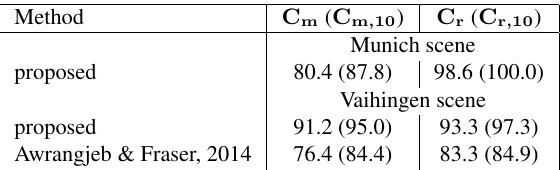
Table 2. Completeness and correctness of the segmentation. Seg- mentation results of the Vaihingen Scene are compared to the re- sults of Awrangjeb and Fraser (2014).